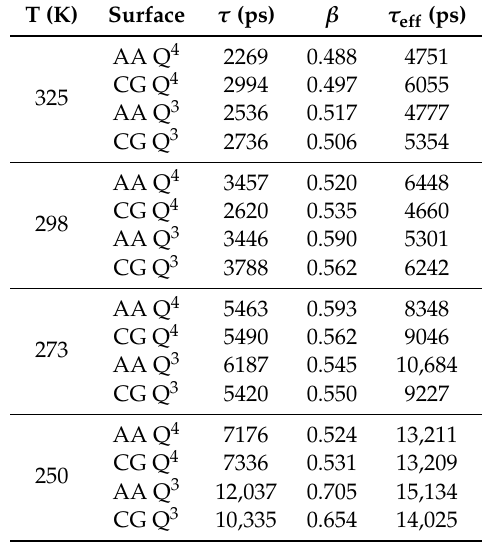
Figure 6. ( a ) φ des for PB in contact with an AA Q 4 silica wall, at different temperatures. The fit to the stretched exponential function is reported with a dashed line. ( b ) τ eff as a function of temperature for AA and CG Q 4 silica wall, and AA and CG Q 3 silica wall ( c ). Table 3. Parameters for the fit of the desorption